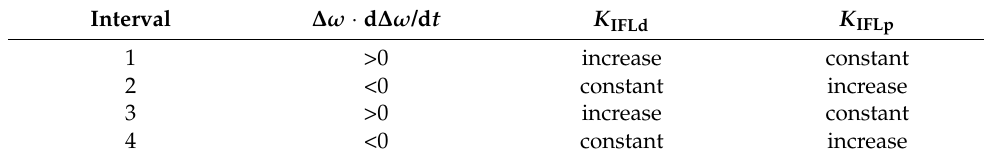
Table 1. Selection rules for K IFLd and K IFLp . Interval ∆ ω · d ∆ ω /d t K IFLd K IFLp 1 >0 increase constant 2 <0 constant increase 3 >0 increase constant 4 <0 constant